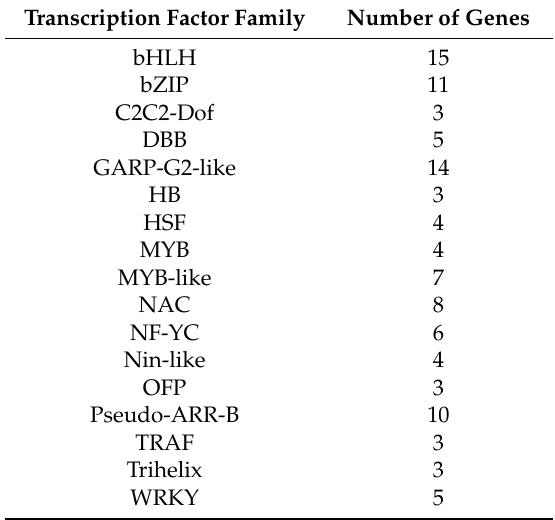
Table 1. Transcription factors differentially expressed in A. splendens . Transcription Factor Family